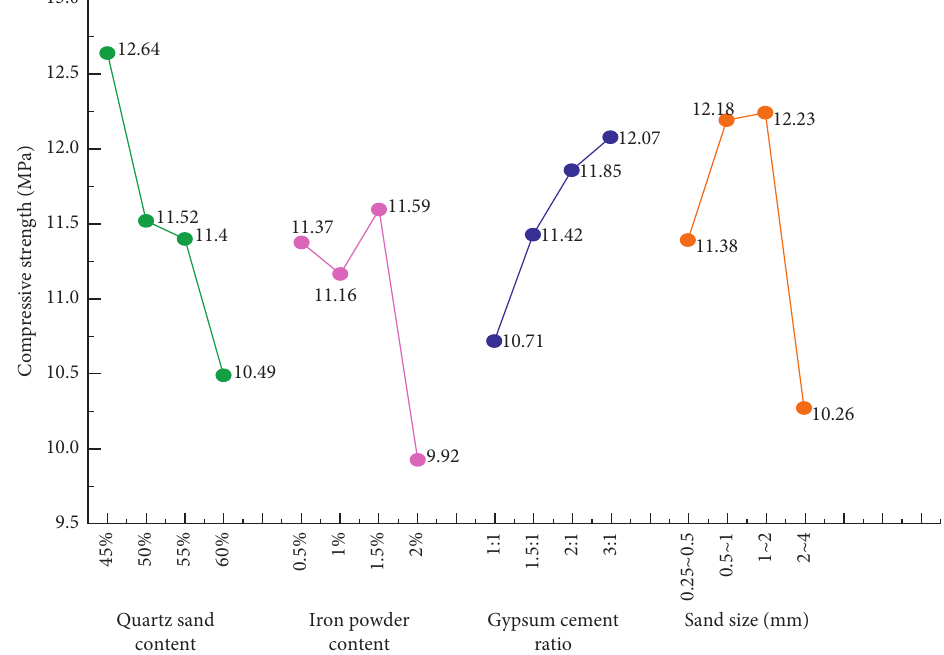
Figure 7: Influence of various factors on compressive strength of similar materials covered by the Table 5: Analysis of the extreme difference in compressive strength of each factor covered by the study. Factor level